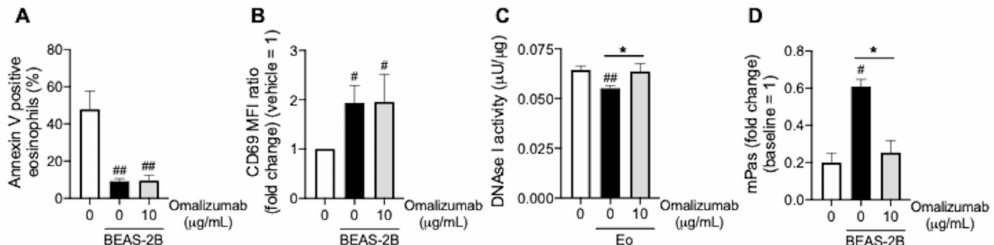
Figure 4. Effects of omalizumab on the DNAse I activity in airway epithelial cells. ( A , B ) Purified peripheral blood eosinophils co-incubated with BEAS-2B cells were treated with omalizumab (10 µ g/mL) overnight. The proportions of Annexin-V-positive eosinophils ( A ) and CD69 expression on eosinophils ( B ) were evaluated. ( C ) BEAS-2B cells co-incubated with purified peripheral blood eosinophils were treated with omalizumab (10 µ g/mL) overnight. The DNAse I activity in BEAS-2B cell extracts was assayed. ( D ) Mucin co-incubated with BEAS-2B was treated with omalizumab (10 µ g/mL) overnight. The mucin viscoelasticity was measured using a viscometer at 10 rpm. Values represent the means ± SEM values of four experiments; # p < 0.05, ## p < 0.01 (vs. non-treatment control), * p < 0.05 (as shown between the two